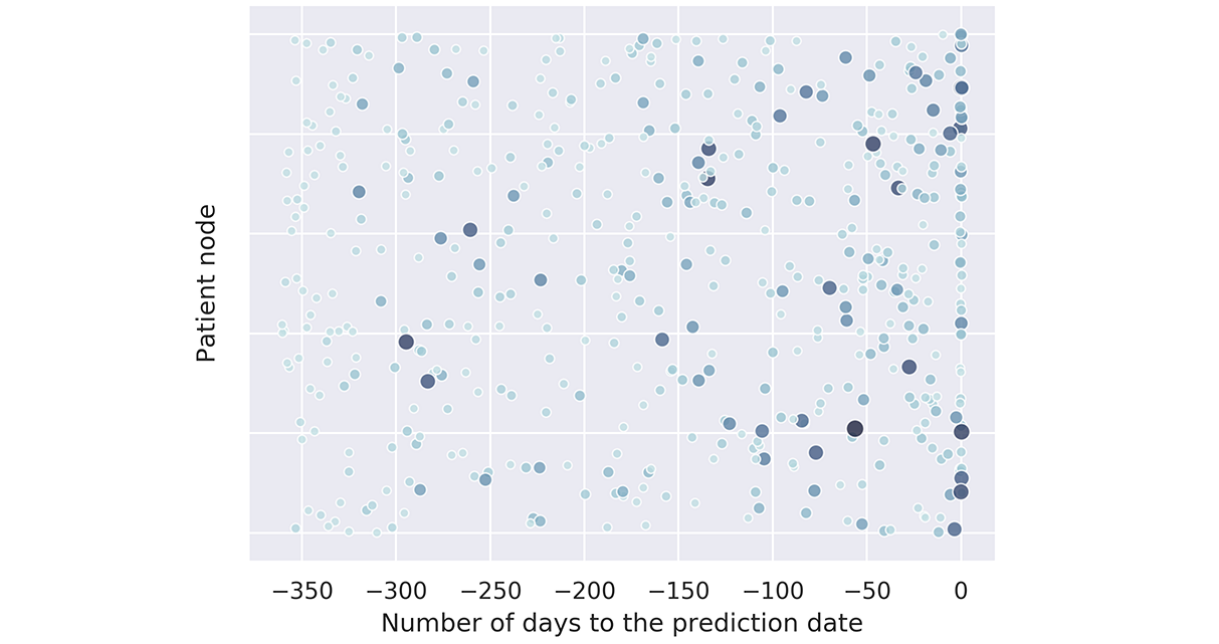
Figure 6. The time distribution of the contribution of the clinical variable